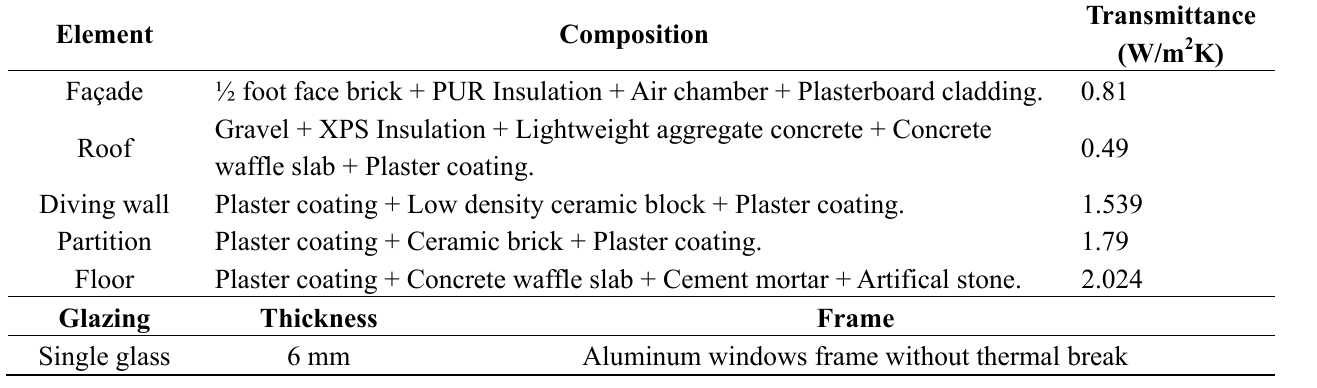
Table A1. Envelope description.